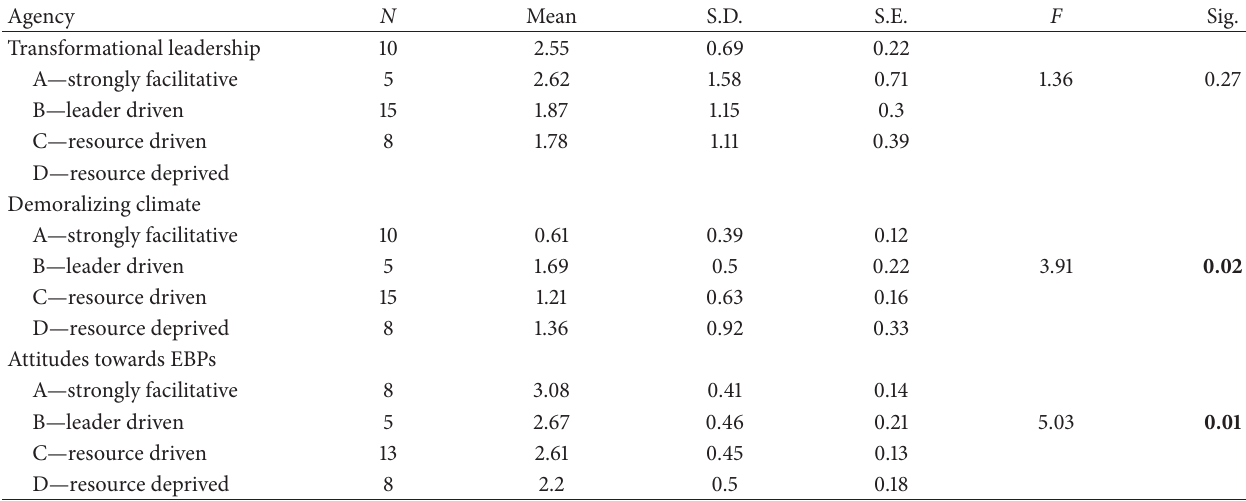
Table 4: Service provider ratings of transformational leadership, demoralizing climate, and EBP attitude by agency.